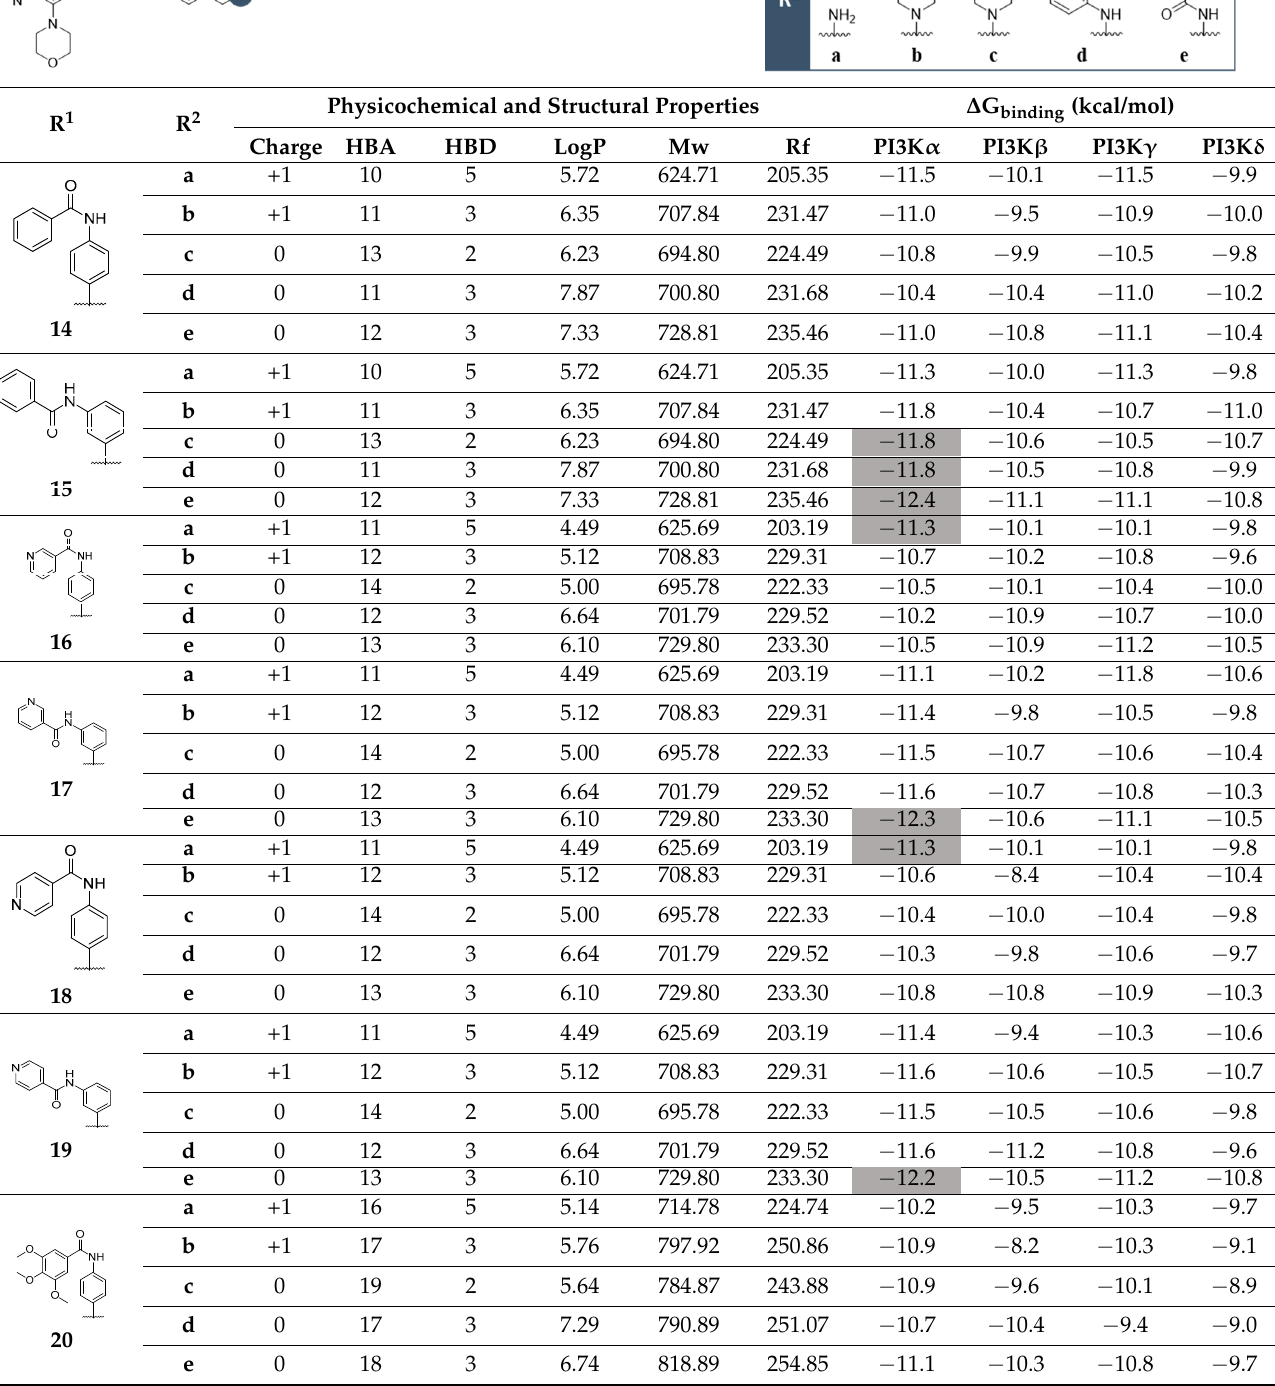
Table 1. Description of the physicochemical and structural properties of the ligands under study and